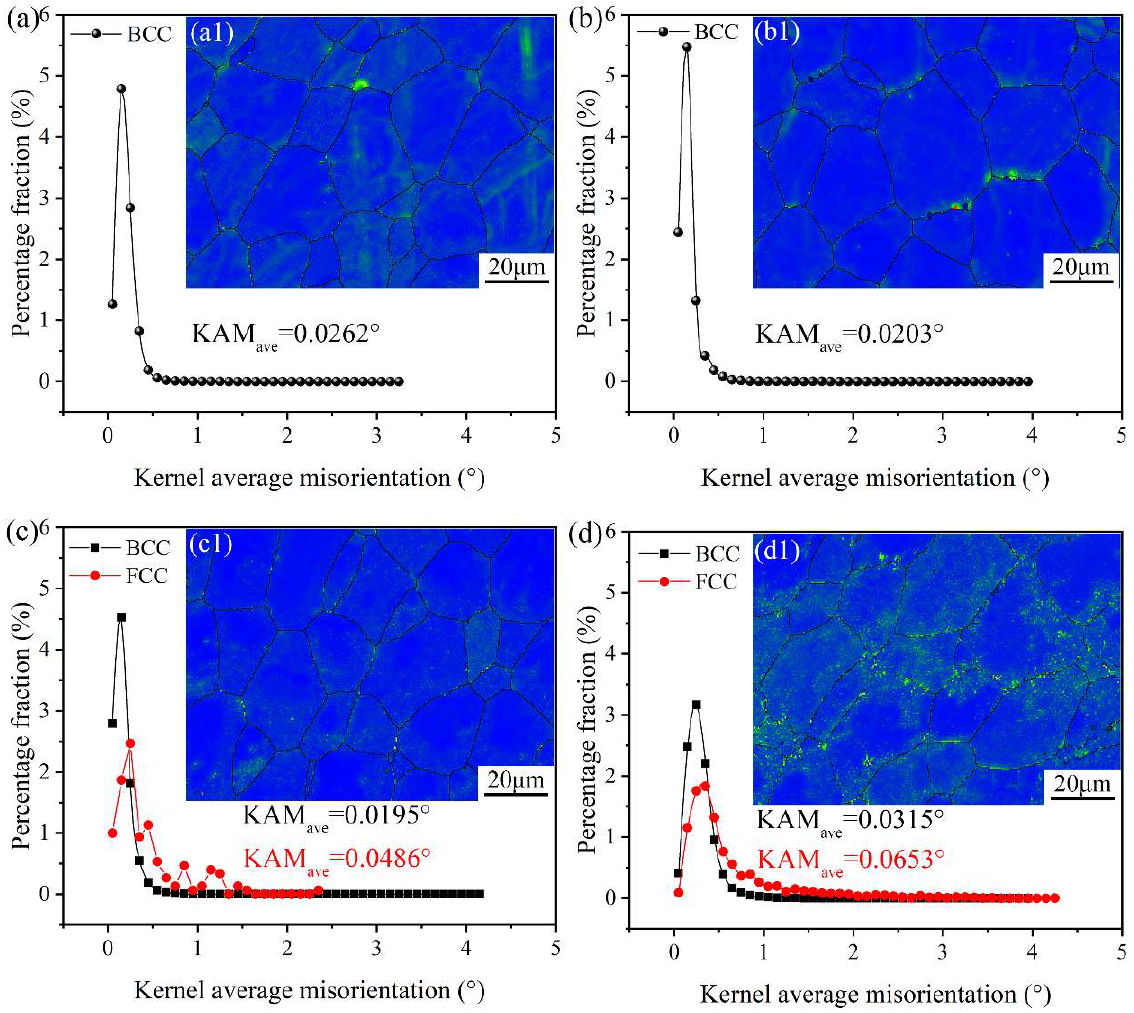
Figure 8. EBSD-KAM detection results and EBSD-KAM distribution curve of the AlCoCrFeNi components before and after high-temperature treatment: ( a , a1 ) as-fabricated; heat-treated at ( b , b1 ) 600 °C; ( c , c1 ) 800 °C; and ( d , d1 ) 1000 °C.